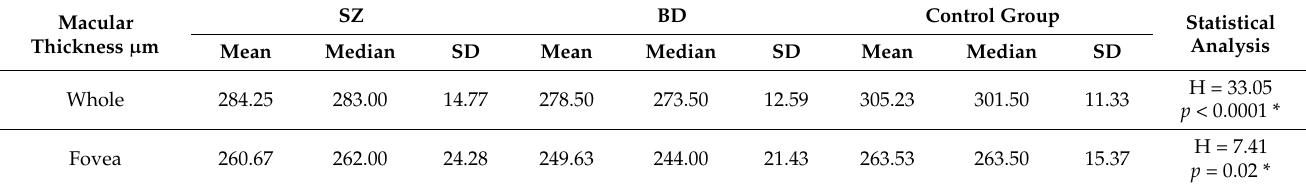
Table 4. Macular thickness in the whole area (6 × 6 mm) and in the fovea in the three groups of